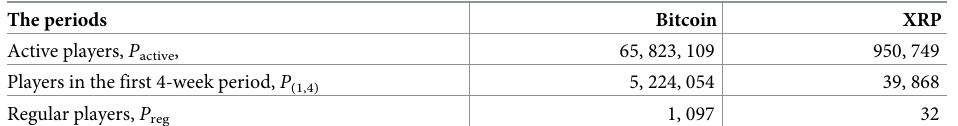
Table 1. Number of participating